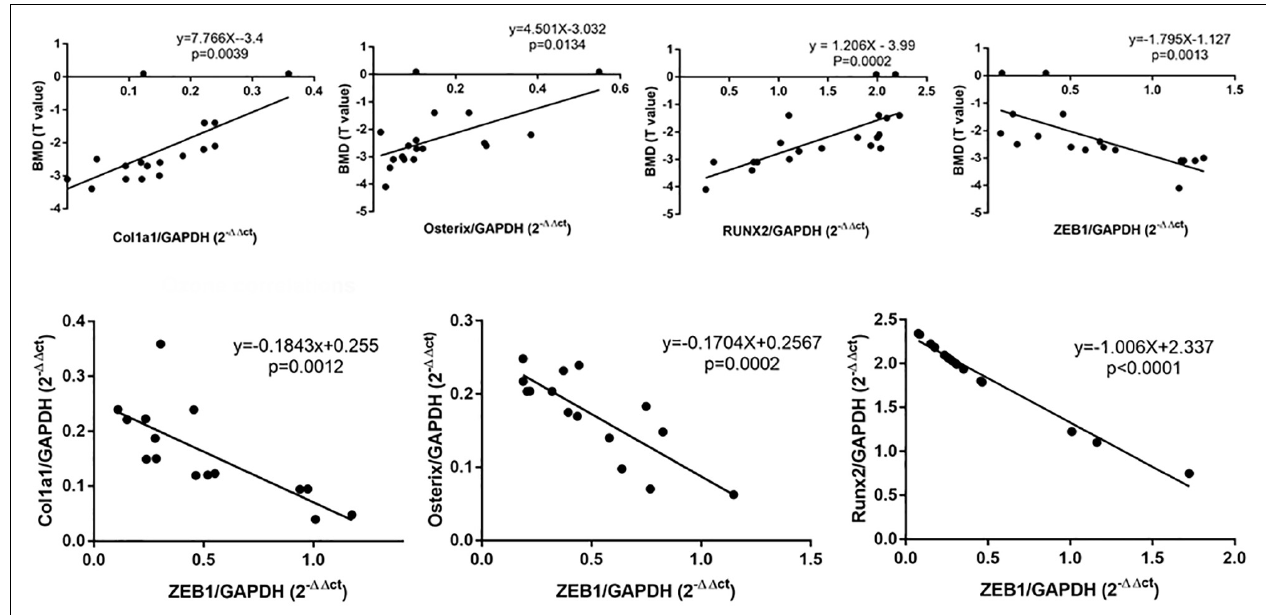
FIGURE 1 | qRT-PCR analysis showed that Col1a1, osterix, and RUNX2 were significantly decreased in PMOP patients-derived bone tissue. Correlation analysis demonstrated that ZEB1 was negatively correlated with BMD and Col1a1, osterix, and RUNX2 in bone tissue derived from PMOP